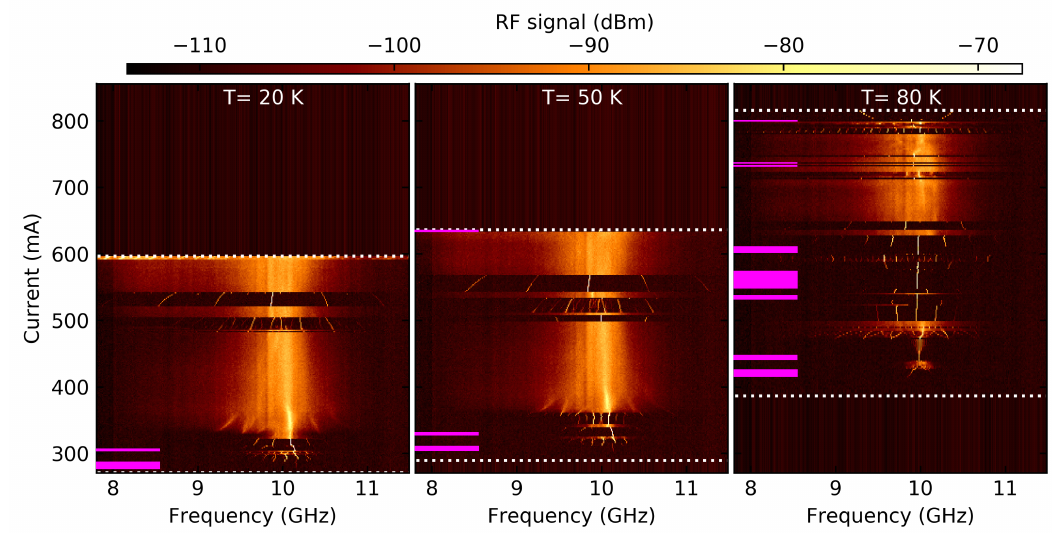
Figure 3. Beatnote maps at 20 K, 50 K and 80 K of the 4 mm long and 64 µ m wide copper device. White dotted line indicates the lasing region and the pink blocks indicate regions with a single narrow beatnote around 9.9 GHz.